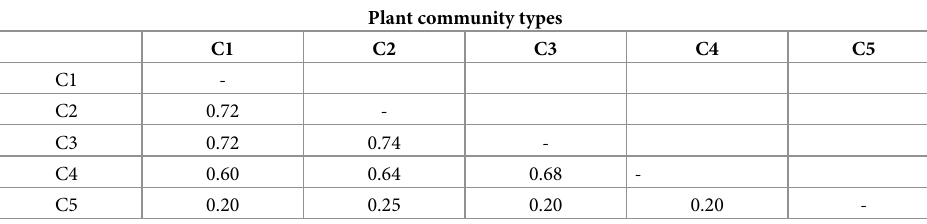
Table 5. Similarity indices of plant communities (C1—C5) in the study